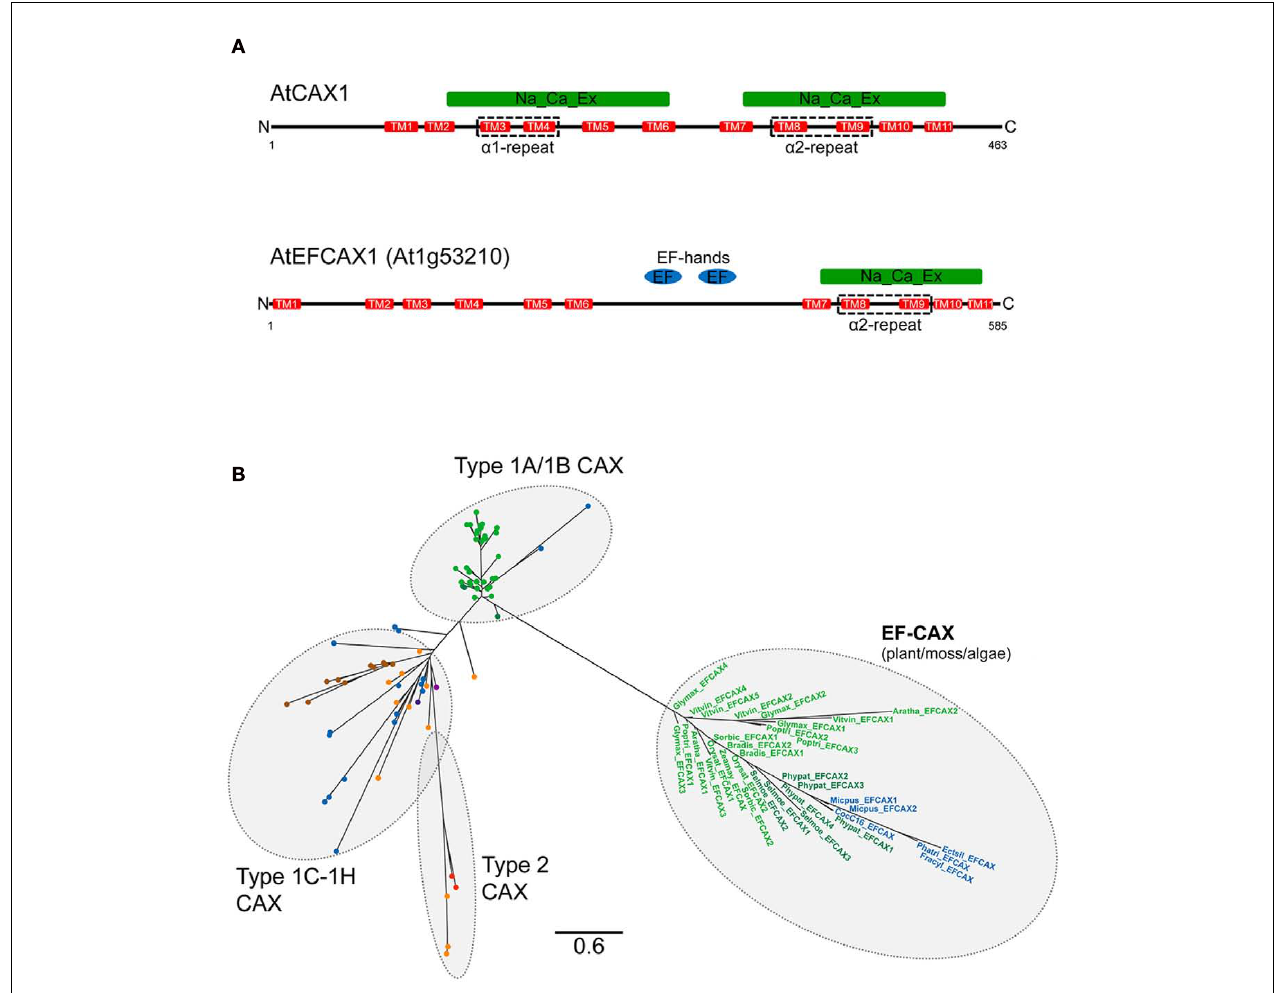
constructed using the maximum likelihood method and derived from alignments of α 2-repeat region sequences extracted from genes identified in the CAX group of the full CaCA tree ( Figure 3 ) and the EF–CAX genes as determined by Pfam analysis.The CAX sub-groups are highlighted in addition to the EF–CAX sub-group. Branch labels include the species name abbreviation defined in Figure 2 or are replaced by a circle and are colored according to the species class using the same color code as in Figure 3 .The branch length scale bar indicates the evolutionary distance of 0.6 amino acid substitutions per